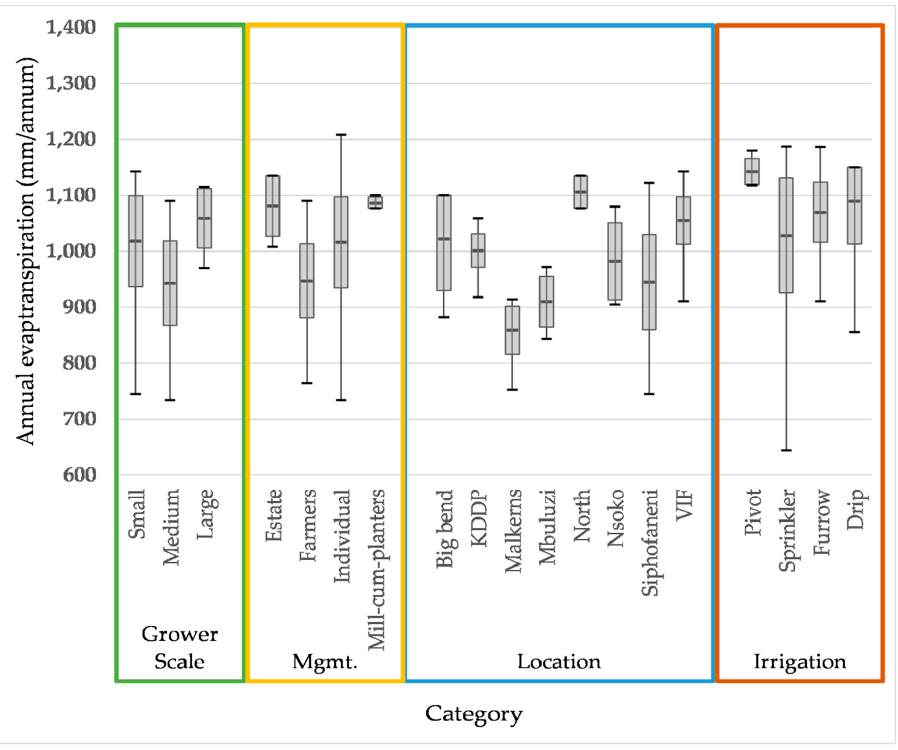
Figure 5. The annual ET for sugarcane in different grower clusters